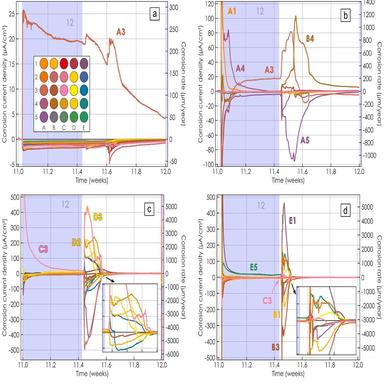
Anodic and cathodic currents in the (a) CEM I specimen, (b) CEM II specimen, (c) CEM III specimen and (d) CEM IV specimen during the 12th week of exposure. CEM III and CEM IV specimens also include detailed view of the drying period with selected electrodes visible.